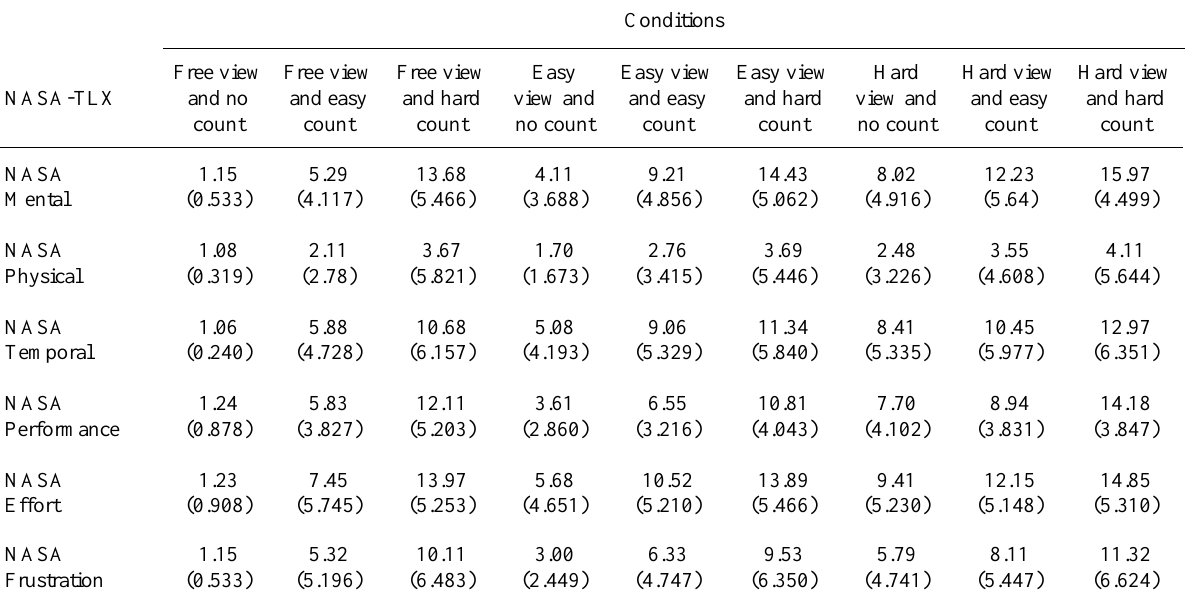
Table 1. Subjective rating of task difficulty.